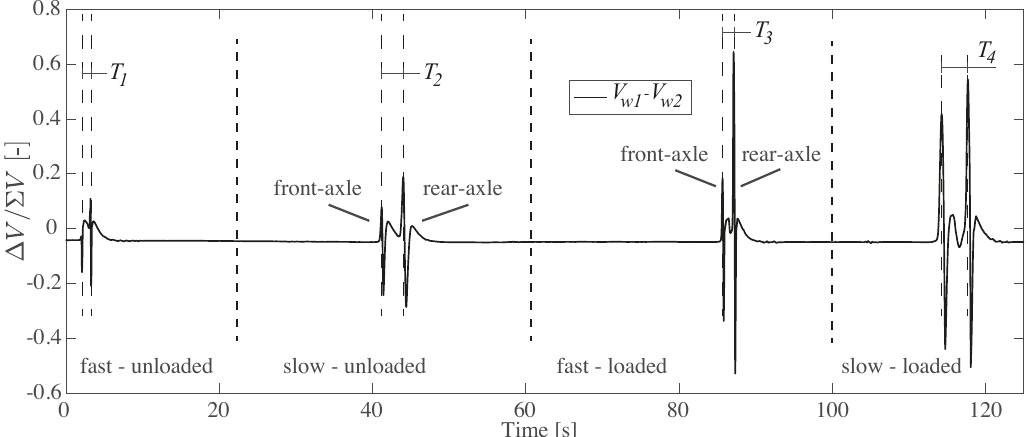
Figure 8. Time series of voltage pulses obtained from the pavement sample during the bicycle pass tests, showing the ratio ∆ V to the total read voltage ( Σ V ) and the time period between front and rear axle occurrences T .